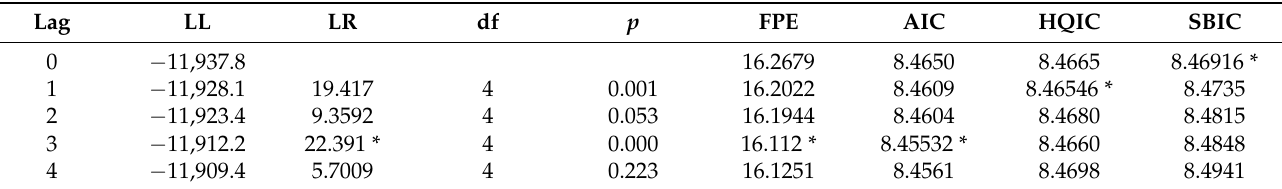
Table 3. Lag order test for WTI and WHF .